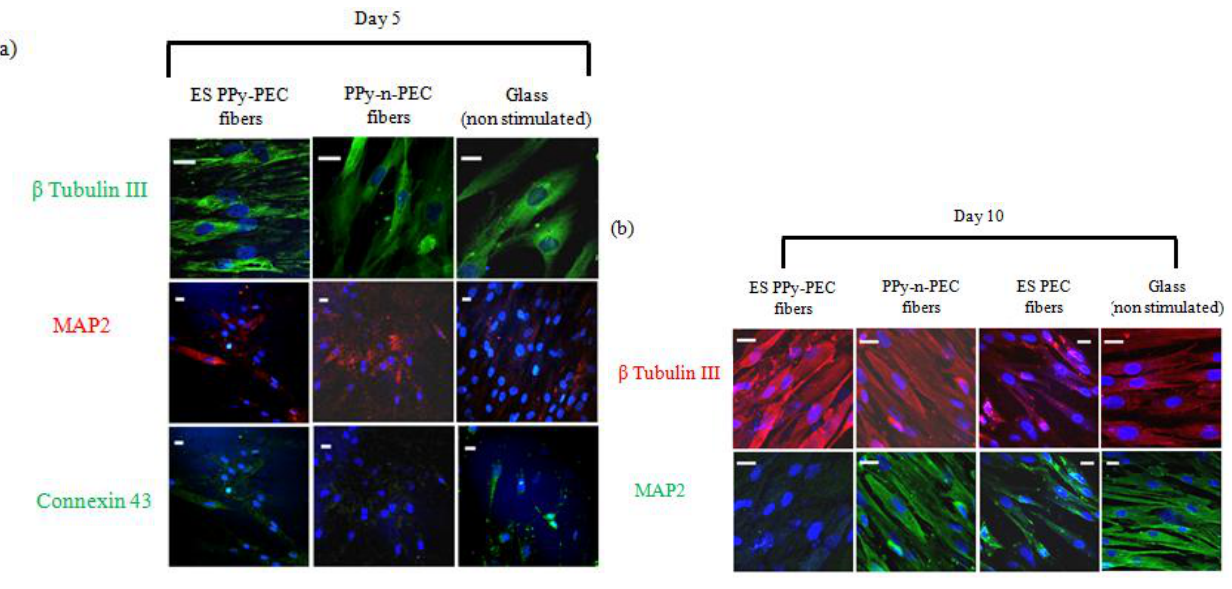
Figure 4. ( a ) Immunofluorescent staining of β tubulin III, MAP 2 and connexin 43 in hMSCs cultured on ES PPy-PEC, PPy-n-PEC and on control samples at day 5. ( b ) Immunofluorescent staining of β tubulin III and MAP 2 in hMSCs cultured on ES PPy-PEC, PPy-n-PEC, ES PEC and control samples at day 10. Scale bar = 20 µm. The cell nuclei in all panels were stained with DAPI and shown in